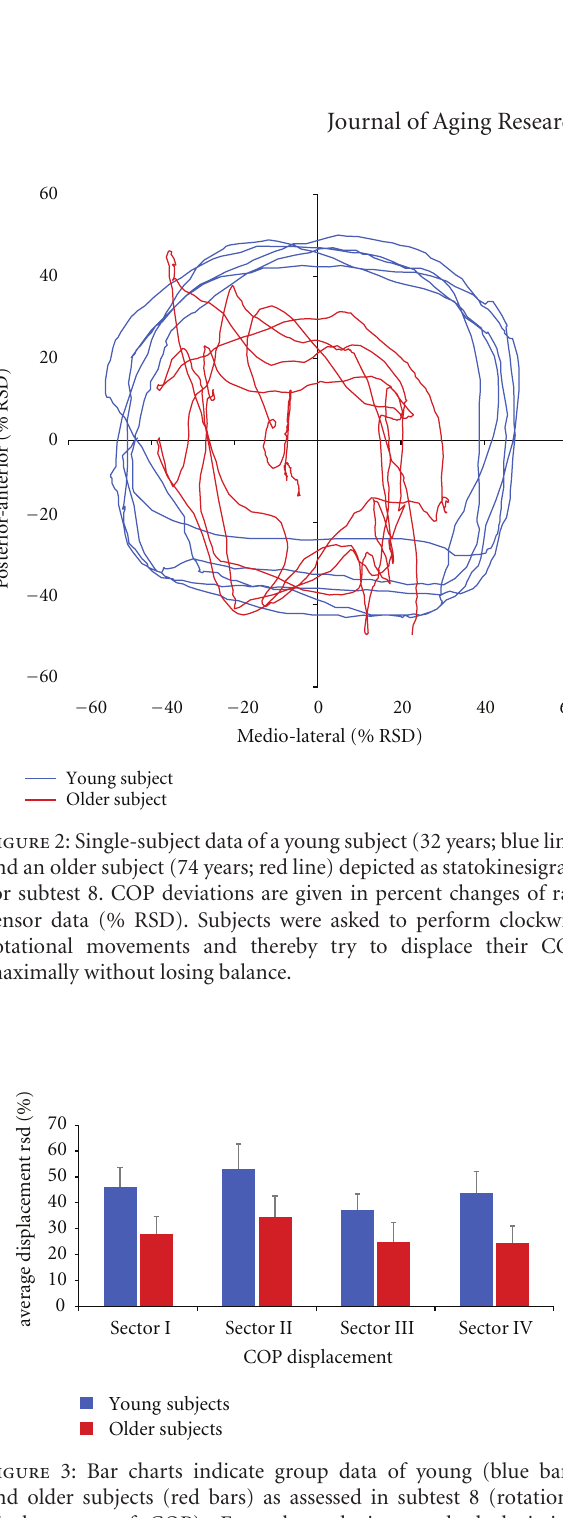
7 . 53%-RSD; II (upper left) : 52 . 97 ± 9 . 74%-RSD; III (lower left) :